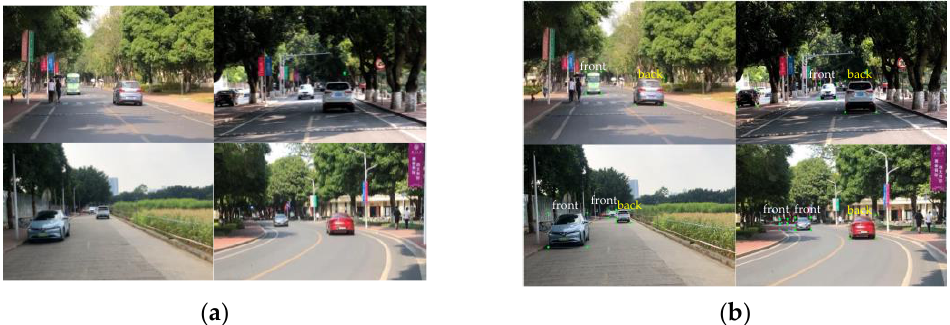
Figure 2. Presentation of data sets. ( a ) Partial sample of data sets; ( b ) Example of annotation.